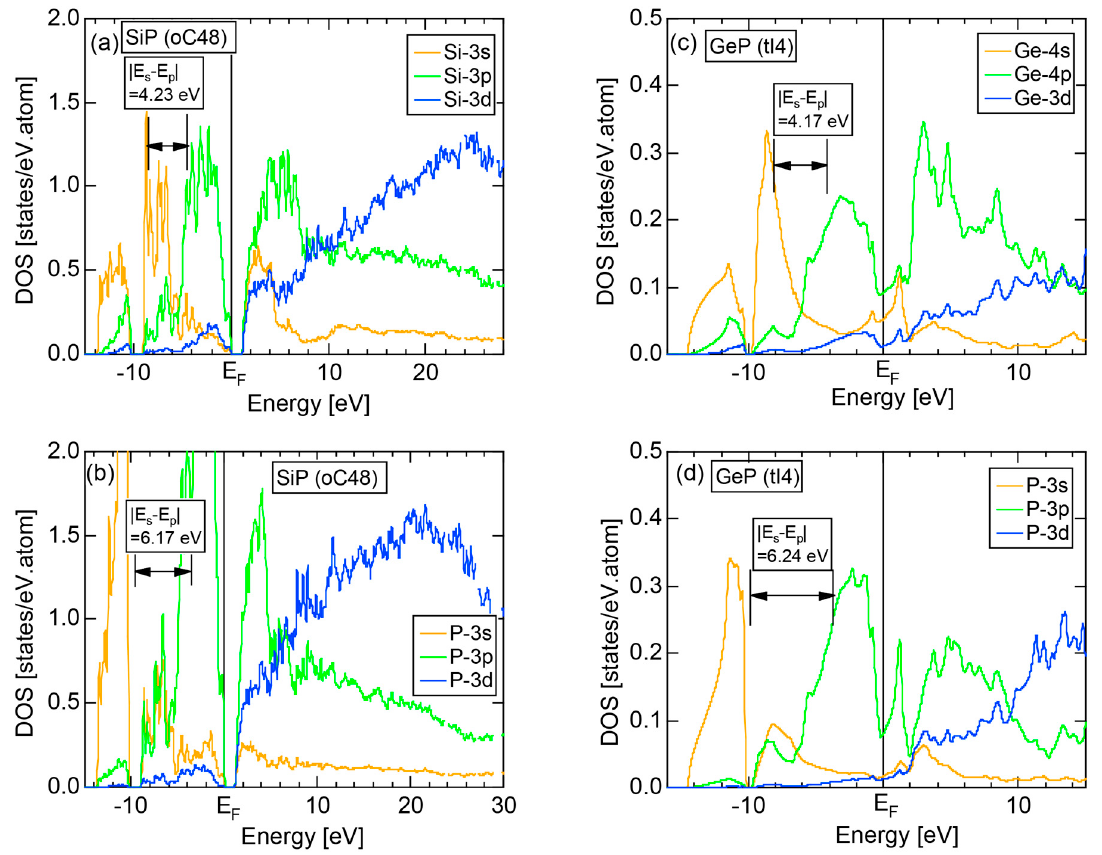
Figure 67. ( a ) Si- and ( b ) P-pDOSs for SiP (oC48) and ( c ) Ge- and ( d ) P-pDOSs for GeP (tI4). The corresponding separation energies are also indicated.